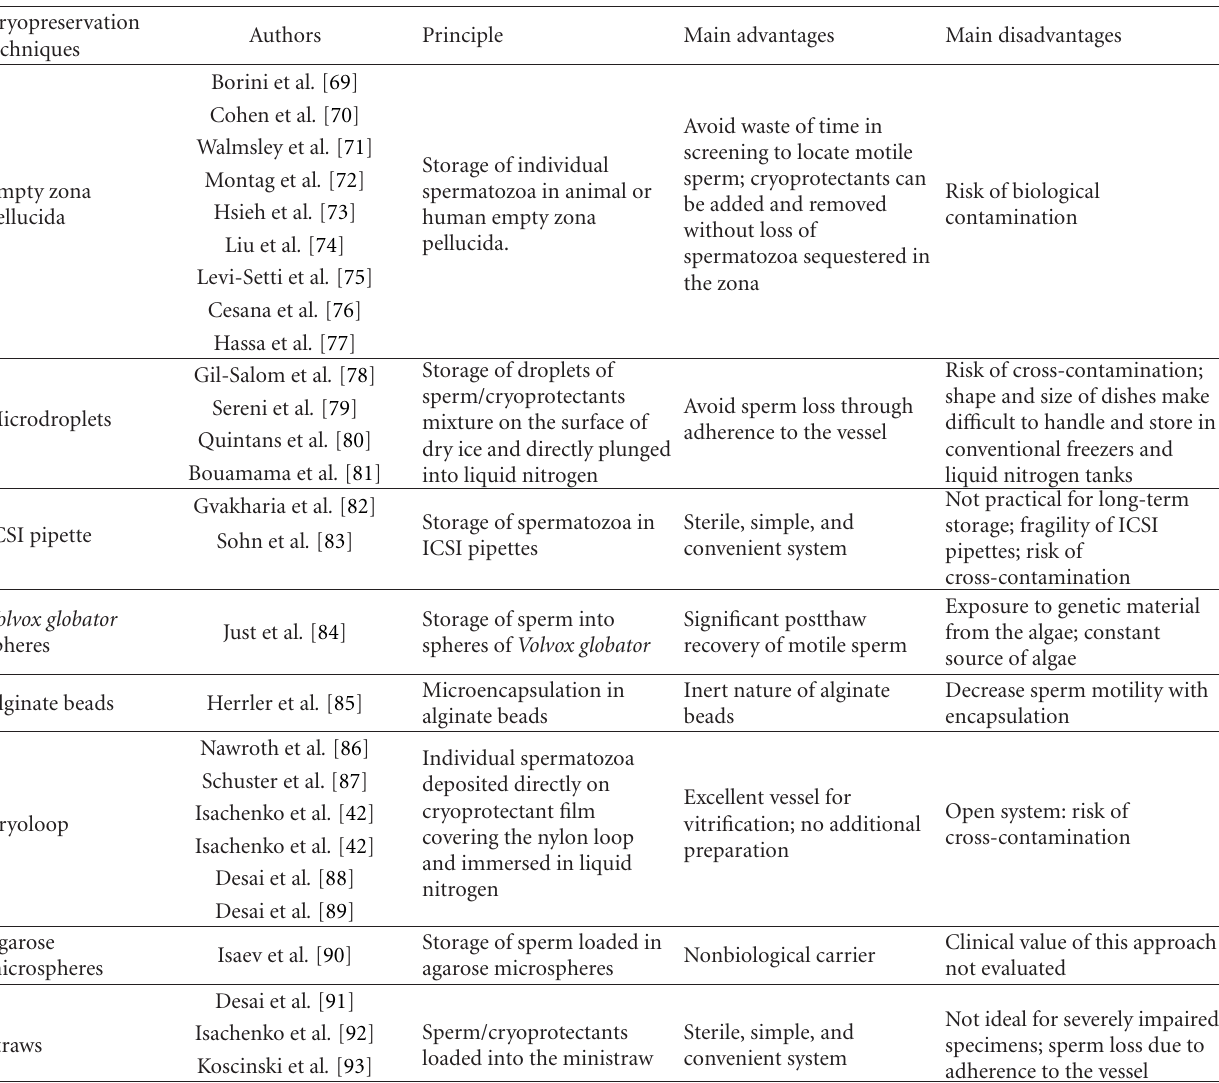
Table 1: Approaches to cryopreserve limited number of